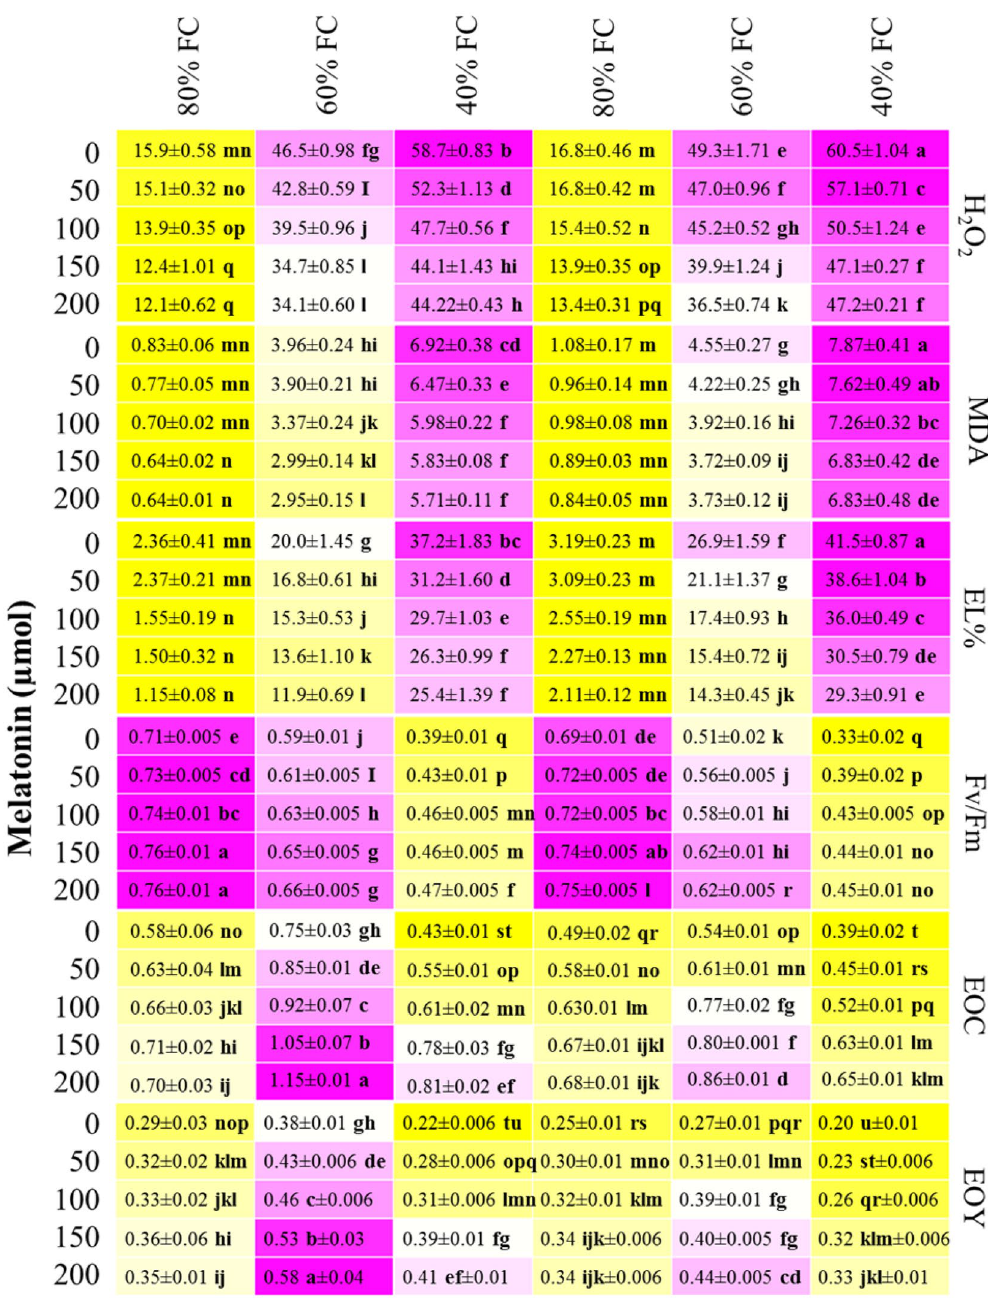
Figure 2. Heatmap representation of the interactive effect of drought stress and melatonin application on H 2 O 2 content (nmol g − 1 ), lipid peroxidation indicated by malondialdehyde (MDA) (nmol g − 1 ), electrolyte leakage (EL%), Fv/Fm ratio, essential oil content (EOC %), and essential oil yield (EOY) (g plant − 1 ) of Salvia nemorosa L., and Salvia reuterana Boiss. Three-way ANOVA test: Means followed by the same letter are not significantly different by the LSD Multiple Range test at P ≤ 0.05. Purple and yellow represent increased and decreased values,